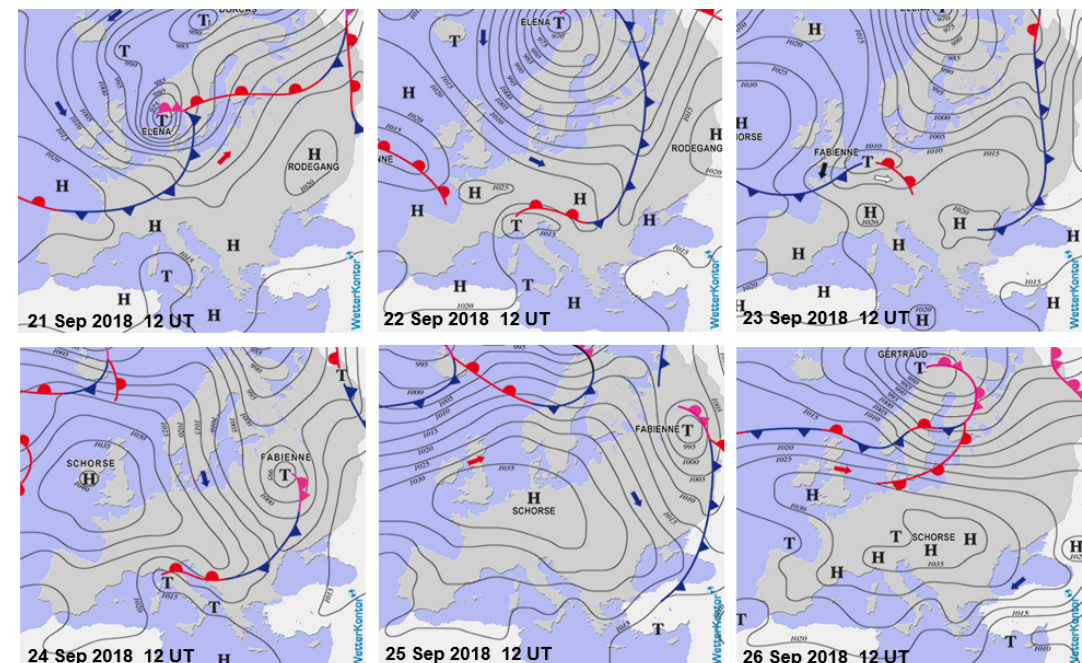
Figure 1. Surface pressure maps provided by Wetterkontor, from https://www.wetterkontor.de, last access: 3 October 2018. Surface pressure is plotted with solid lines with 5hPa steps. Atmospheric fronts (red curved lines with red semi-circles that point in the direction of the warm front, blue curved lines with blue triangles that point in the direction of the cold front and purple lines with alternating triangles and semi- circles pointing in the direction that the occluded front is moving) and the locations of the centers of high ( H ) and low ( T ) pressure systems are also